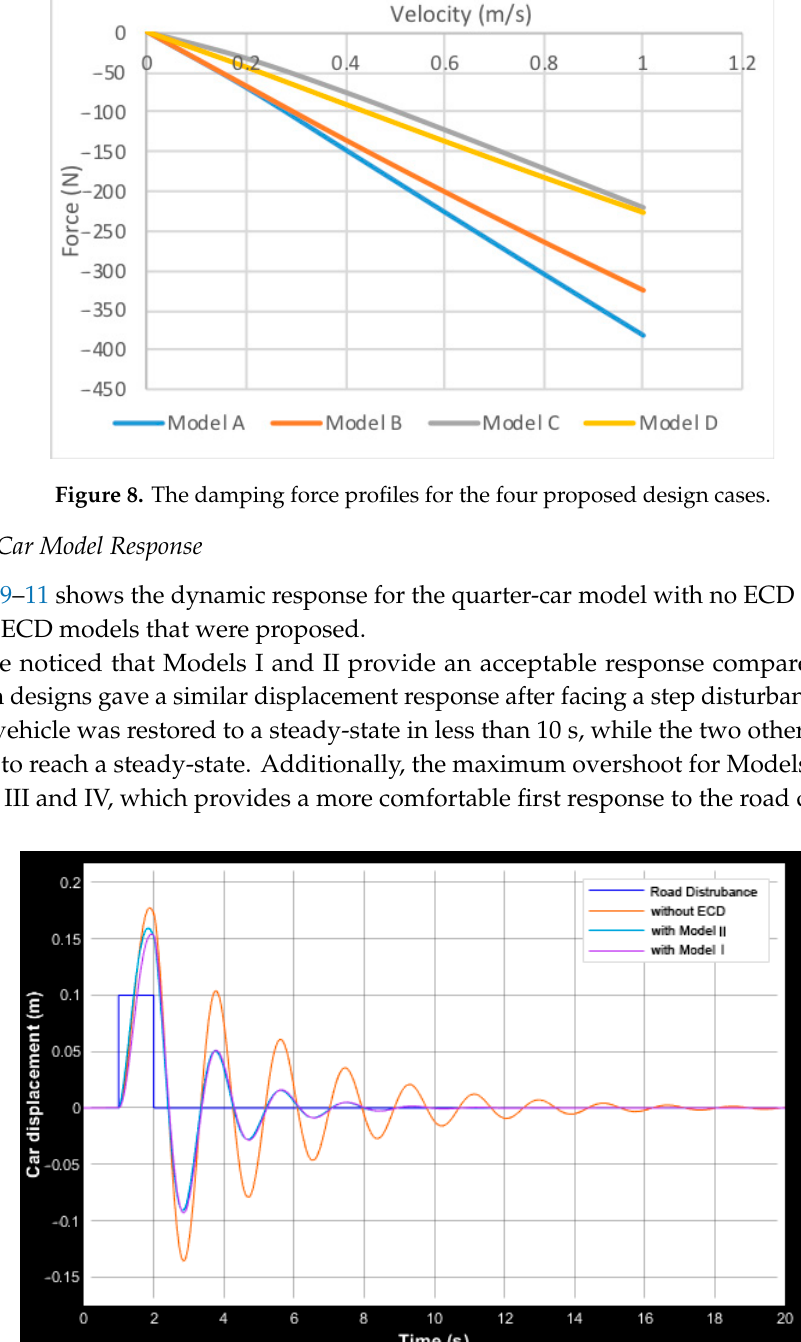
Figure 9. Comparison between the suspension displacement response during road disturbance, between Models I and II.